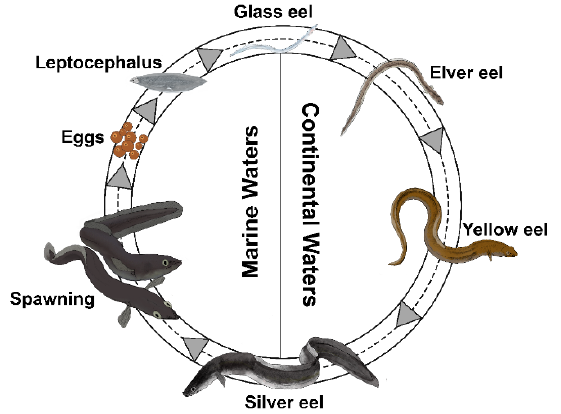
Figure 1. The life cycle of the European eel ( Anguilla anguilla ).